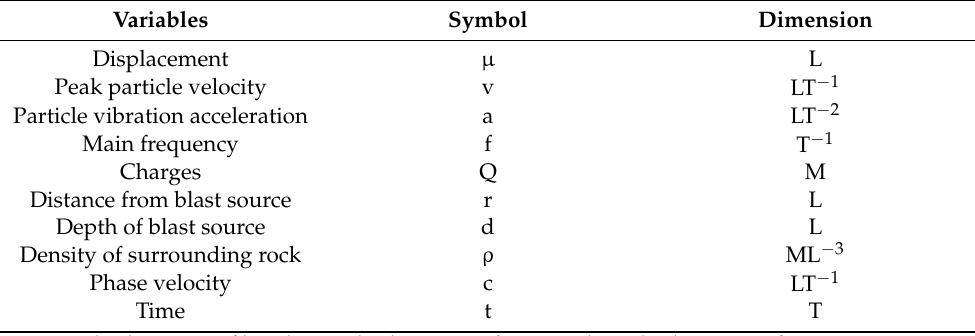
Table 3. Variables associated with surface PPV affected by the blasting excavation of the water conveyance